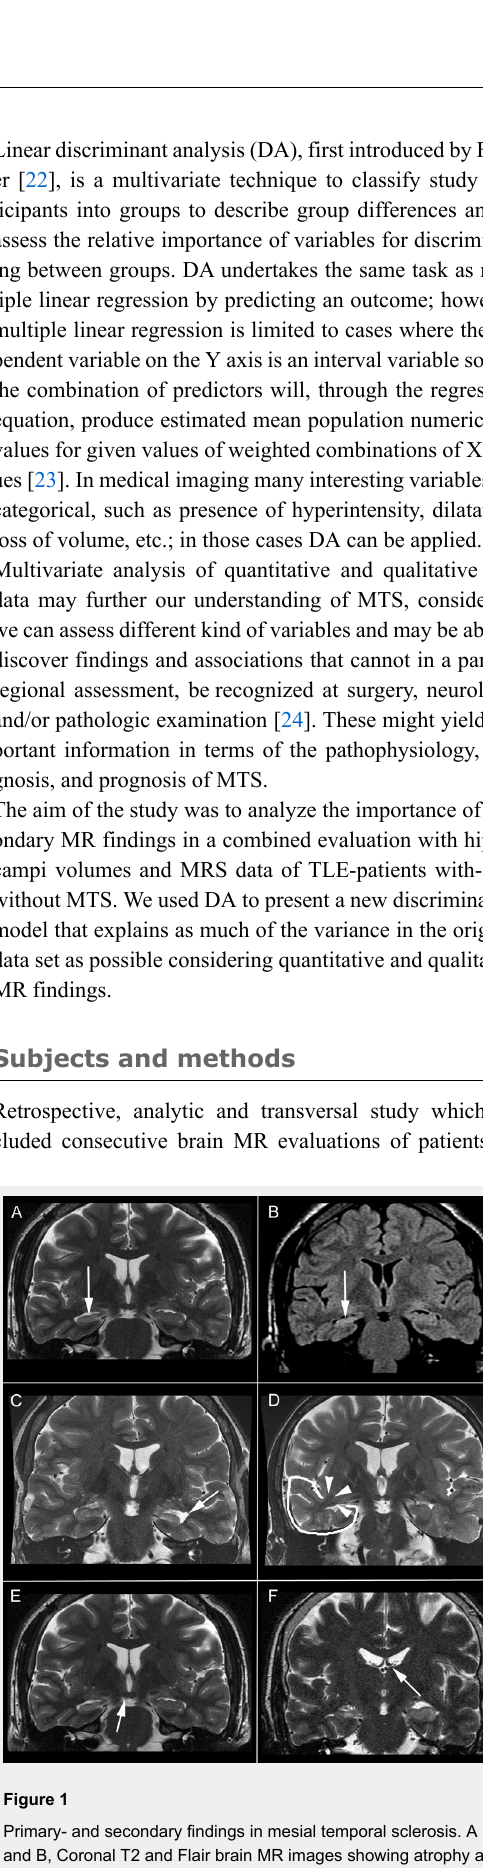
Primary- and secondary findings in mesial temporal sclerosis. A and B, Coronal T2 and Flair brain MR images showing atrophy and hyperintensity in the right hippocampus (white arrows). C, choroidal fissure dilatation. D, temporal lobe atrophy (white contour) and collateral white matter atrophy (white arrow heads). E, mamillary body asymmetry. F, fornix asymmetry.